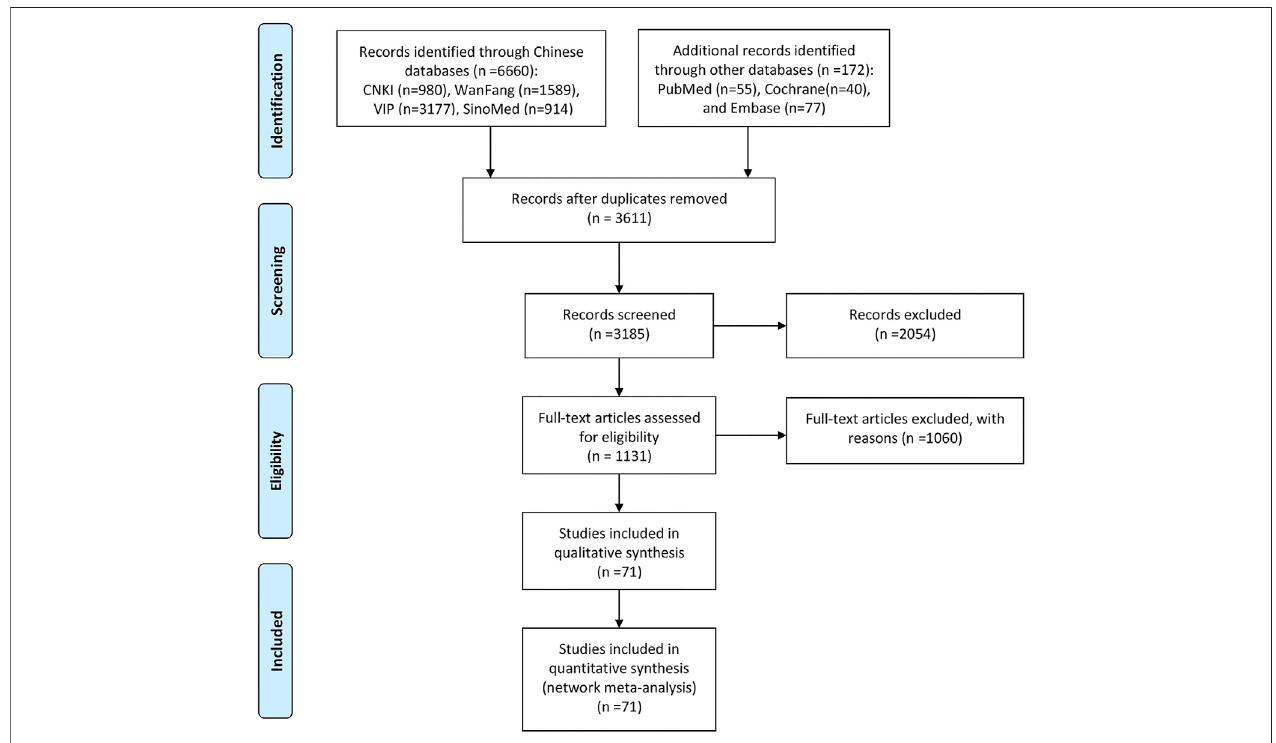
FIGURE 2 | Flow chart of the search for eligible studies. Note: n, number of articles. CNKI, China National Knowledge Infrastructure; WanFang, the WanFang Database; VIP, the Chinese Scienti fi c Journals Full-Text Database; and SinoMed, the Chinese Biomedical Literature Database.